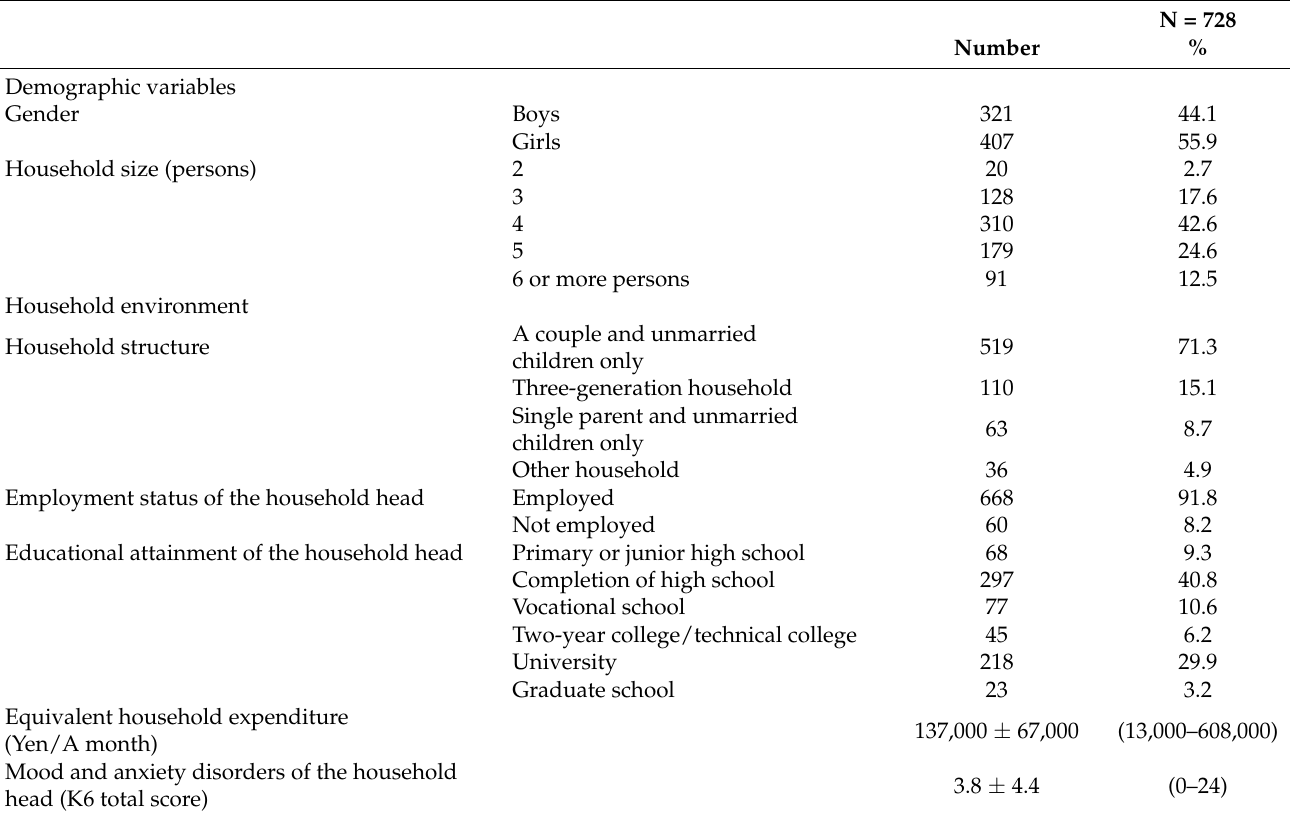
Table 1. Demographic characteristics of adolescents and their household environment.